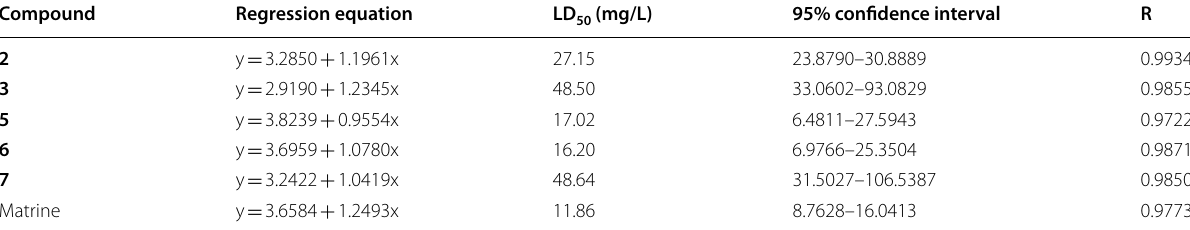
a In CDCl b Overlapped signals are reported without designating multiplicity 3 , NMR at 400 MHz; Table 3 Toxicity of compounds 2 , 3 , 5 – 7 and matrine against D. citri during 6 days after treatment Compound